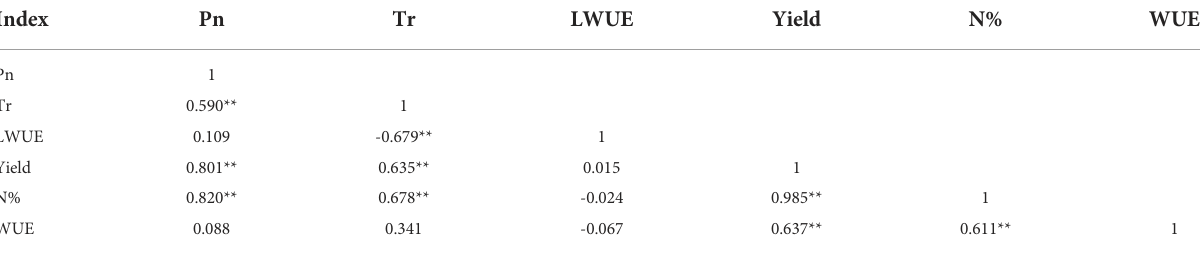
Pn, Photosynthesis rate; Tr, transpiration rate; LWUE, Leaf water use ef fi ciency; WUE, water use ef fi ciency. N%, nitrogen use ef fi ciency. * means signi fi cant correlation at 0.05 level, and ** means extremely signi fi cant correlation at 0.01